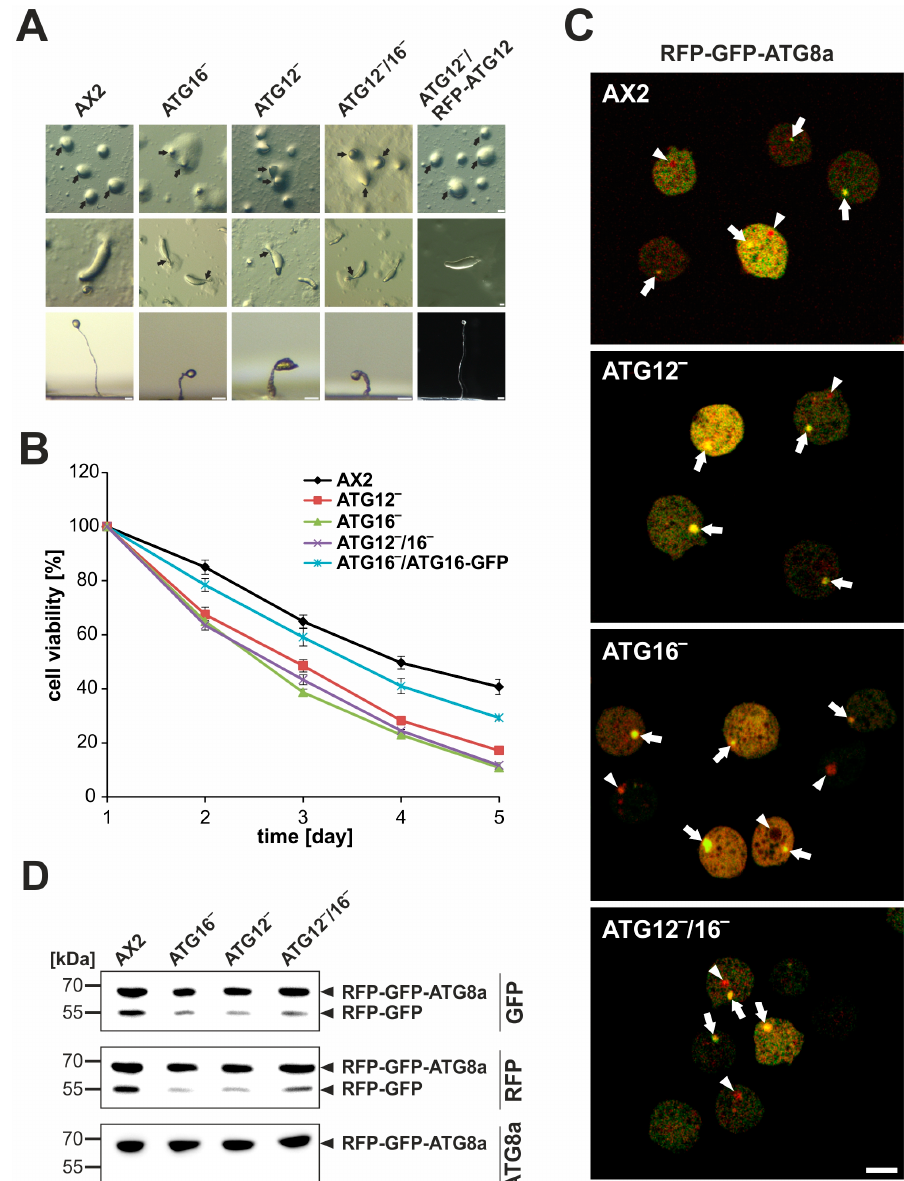
Figure 3. Development, cell survival upon nitrogen starvation, and autolysosome formation of AX2 and different knock-out strains. ( A ) Development of mutant strains on phosphate agar plates is severely impaired. Shown are three developmental stages. Top row: Top view of the tipped mound stage. Wild-type AX2 cells generated only one tip per mound while mutant strains generally produced two or three tips per mound (black arrows). Middle row: Top view of the slug stage. Slugs of mutants were thinner than AX2 slugs and frequently broke apart (black arrows). Bottom row: Side view of terminally differentiated fruiting bodies. In comparison to AX2 cells, the generated fruiting bodies of the mutants were much smaller (please note the different scale), were misshapen, and had a thickened stalk. Expression of RFP-ATG12 in the ATG12 mutant background completely rescued the developmental phenotype. Scale bar is 25 µ m. ( B ) Cell survival of AX2 and mutant cells. The different strains were maintained in SIH medium without amino acids for five days. Cell survival was assessed by counting the number of colony-forming units (CFUs) on a lawn of K. aerogenes at the indicated times. CFUs at day 1 was set to 100% for each strain. The difference between AX2 and the knock-out strains was extremely significant from day 2 to day 5. For statistical analysis Tukey’s test was used as post hoc analysis.